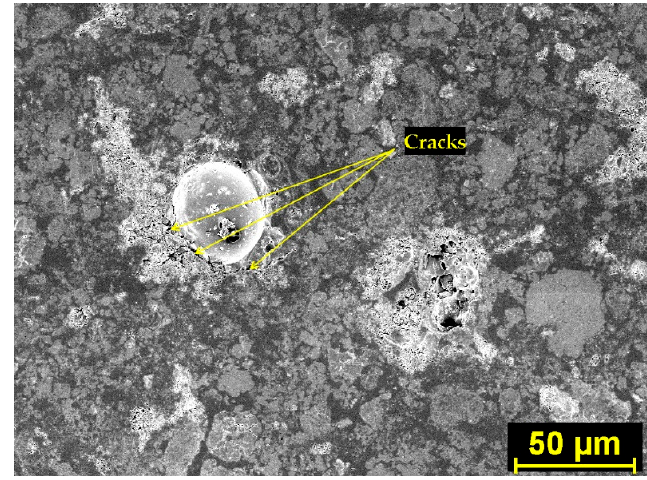
Figure 6. SEM image of microcracks in hardened B1.5 mixture around the SAP core.